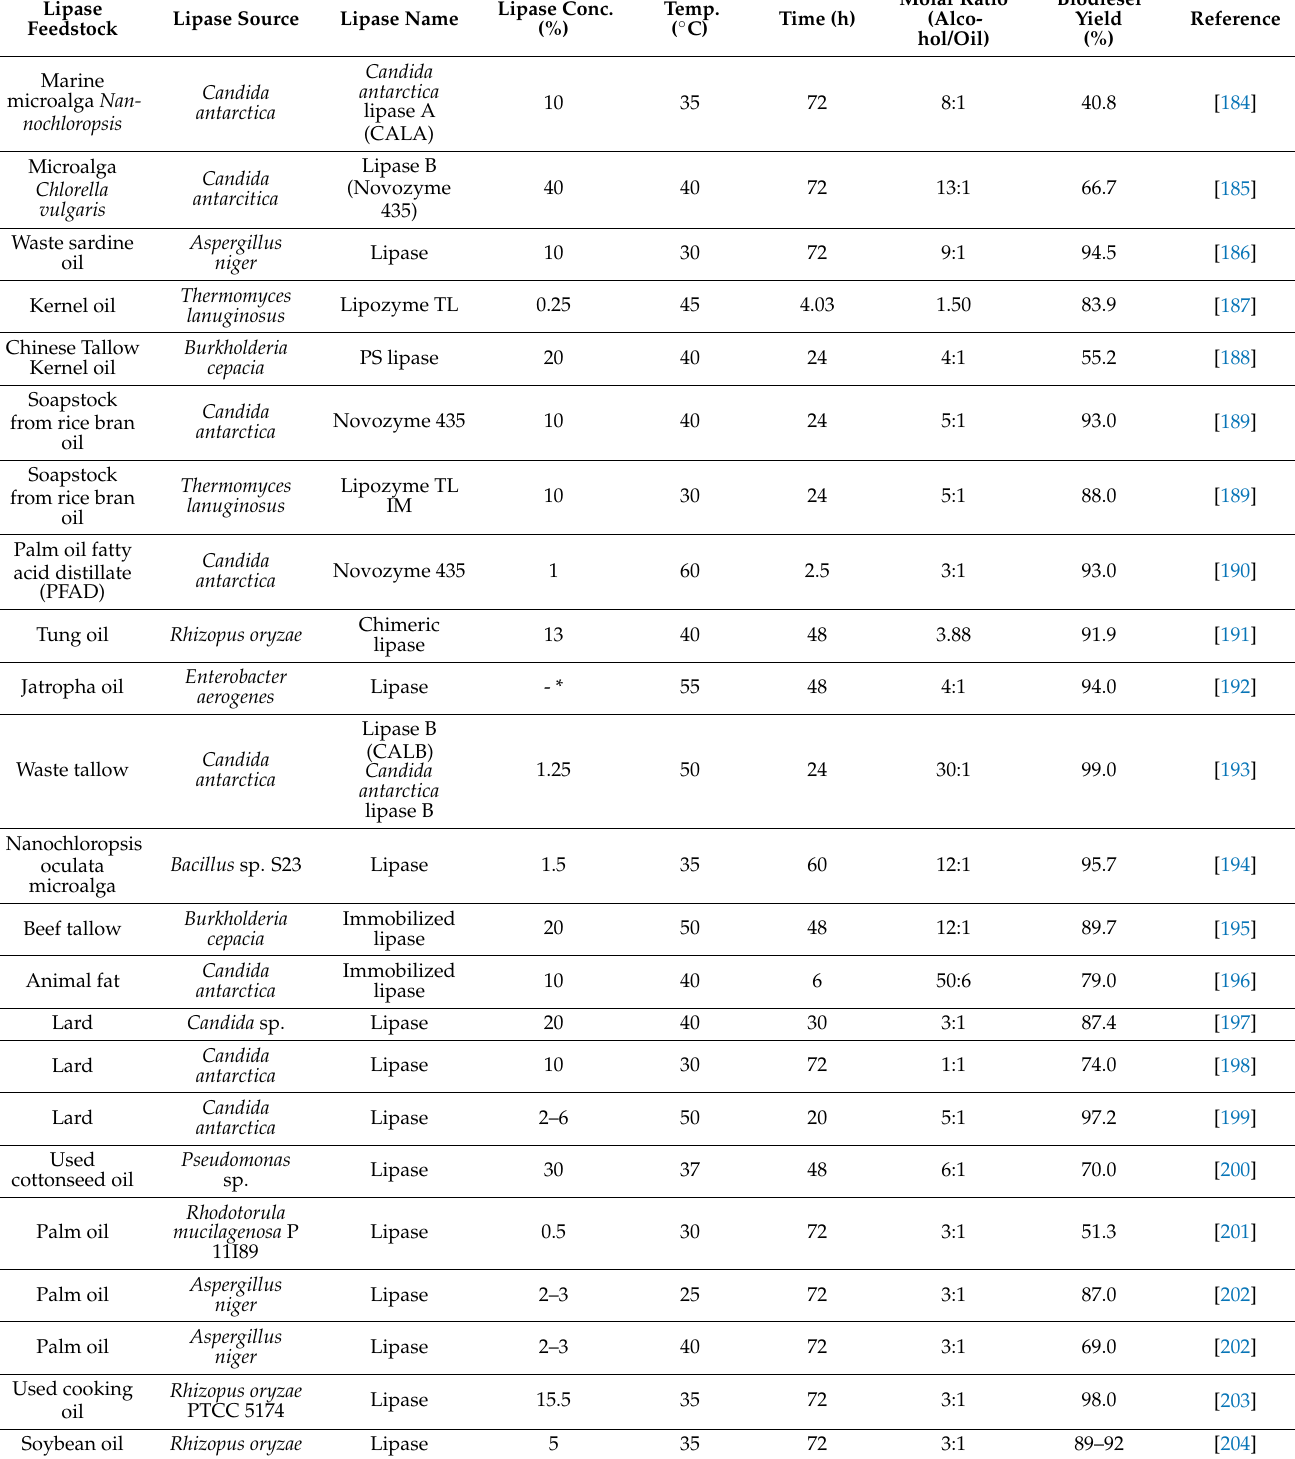
Table 5. Lipase reaction parameters and biodiesel